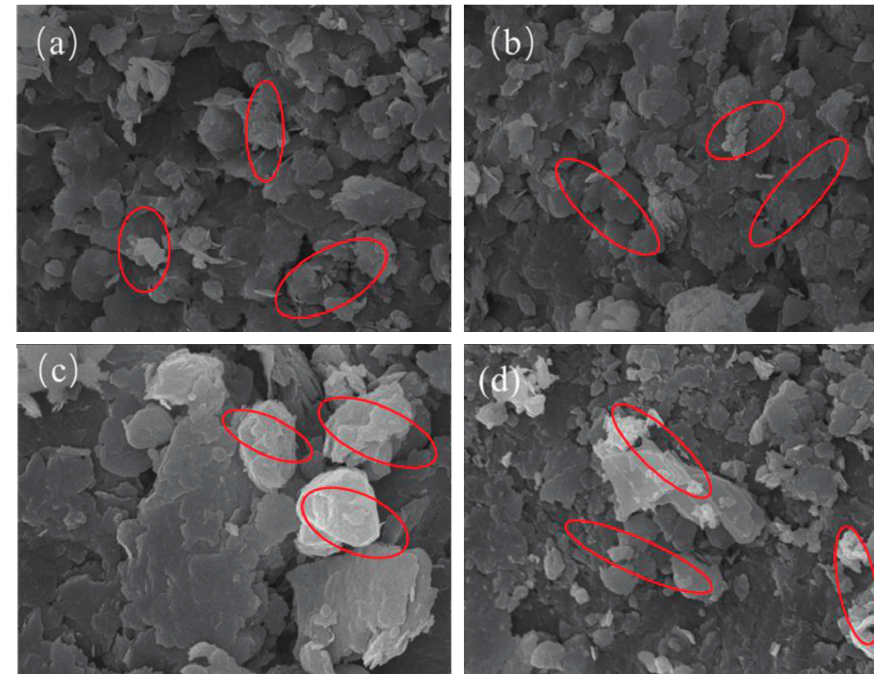
Figure 9: SEM micrographs of (a) 2 times, (b) 4 times, (c) 6 times, and (d) 8 times. Some crystals are marked with